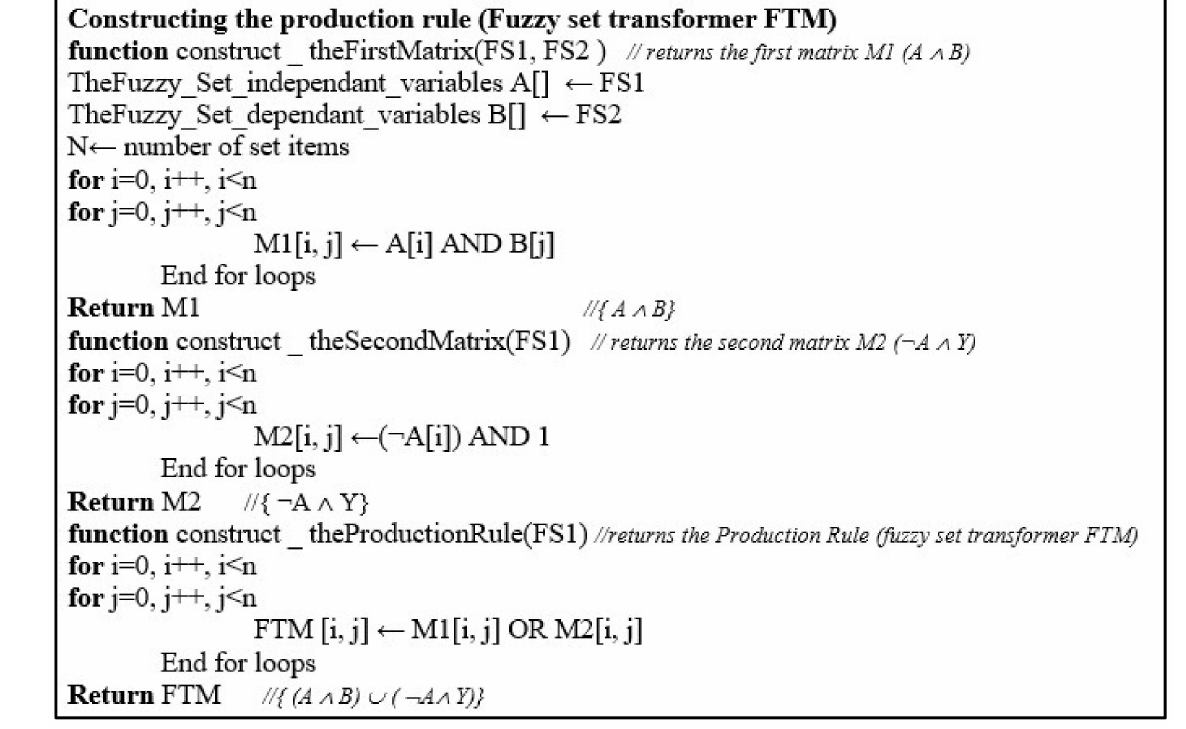
Figure 4. Constructing the production rule (FTM) algorithm.